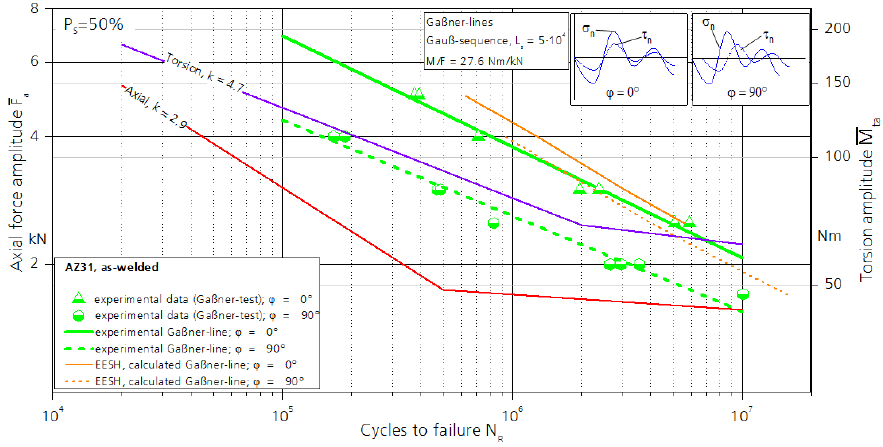
Figure 11: Experimental Gassner-curves and Gassner-curves computed using EESH.